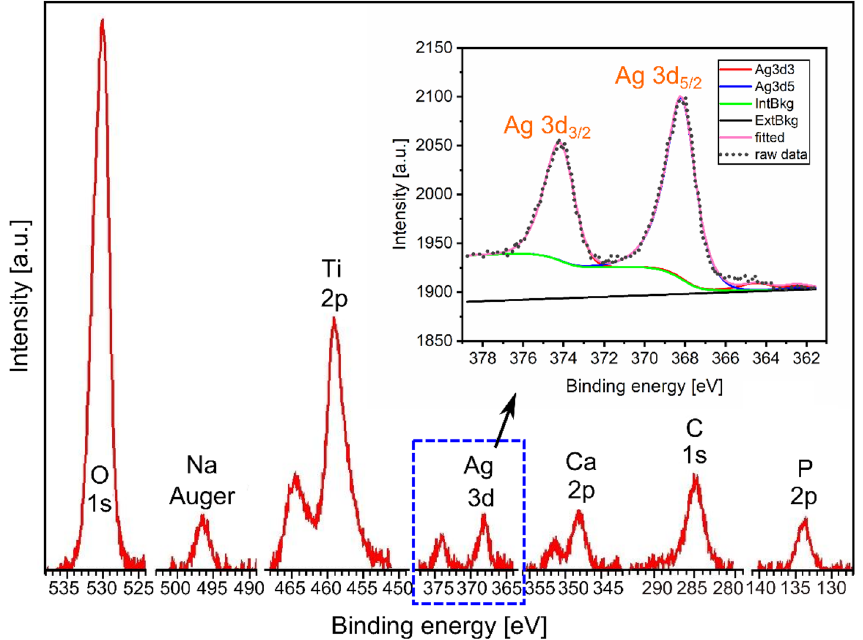
Figure 4. XPS spectrum presenting peaks (without carbon) obtained from the surface of MAO coating (spectrum of the Ag-3d level shown as inset).